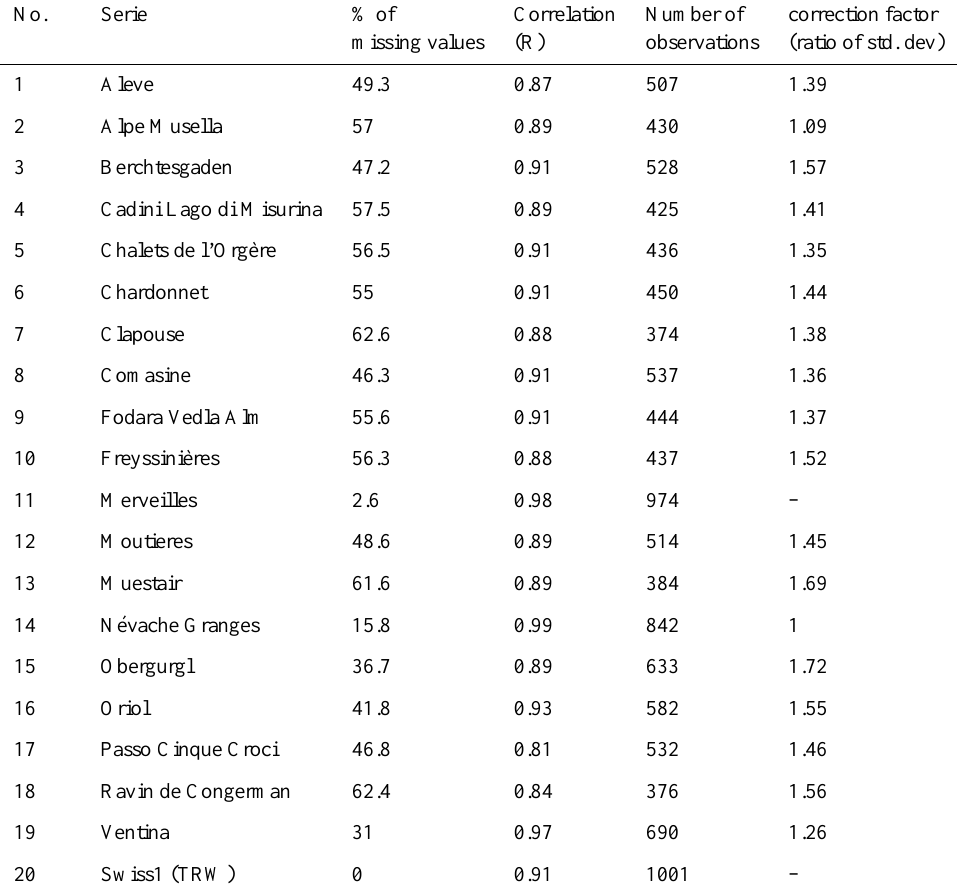
Table 3. Estimation of the missing data by analogue method. The first column represents the percentage of missing values considering the period AD 1000–2000 as 100%. The statistics are calculated between observed values and estimates, when they are available. All correlation coefficients are significant (at the 5% level). No. Serie % of Correlation Number of correction factor missing values (R) (ratio of std.